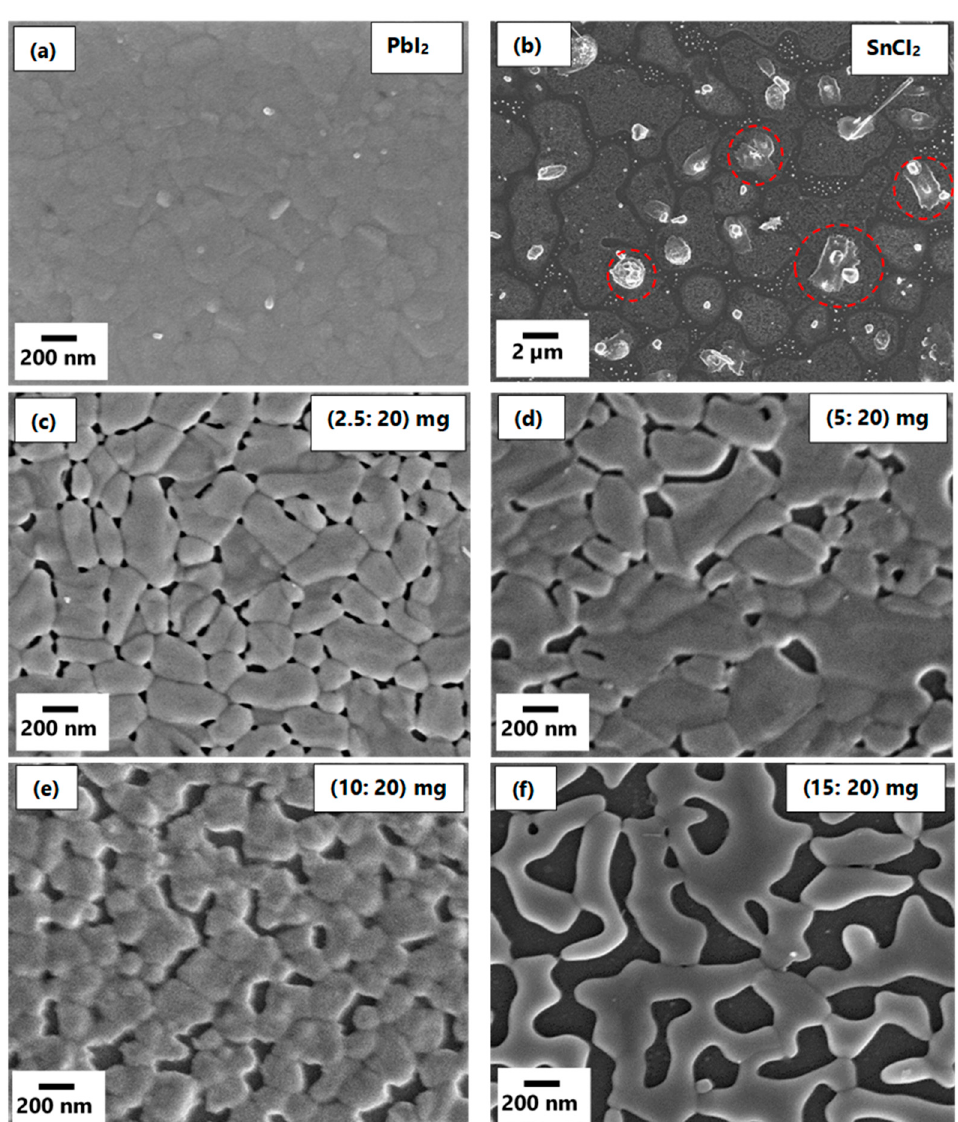
Figure 1. SEM micrographs of ( a ) PbI 2 film, ( b ) SnCl 2 films and ( c – f ) mixed metal -halide thin films.